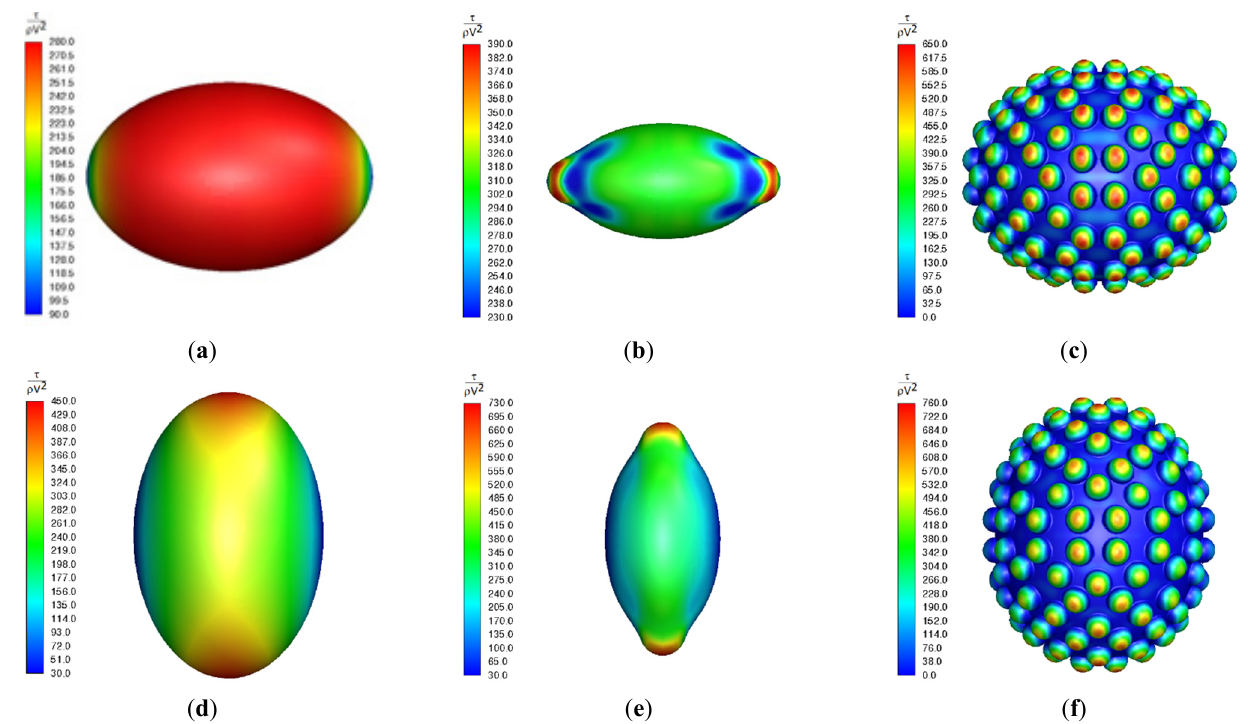
Figure 11. Dimensionless shear stress distribution over egg surface, for Re = 0.01, ( a ) OES, θ = 0°, ( b ) TRI, θ ° = 0, ( c ) ASC, θ = 0°, ( d ) OES, θ = 90°, ( e ) TRI, θ ° = 90, ( f ) ASC, θ = 90°.